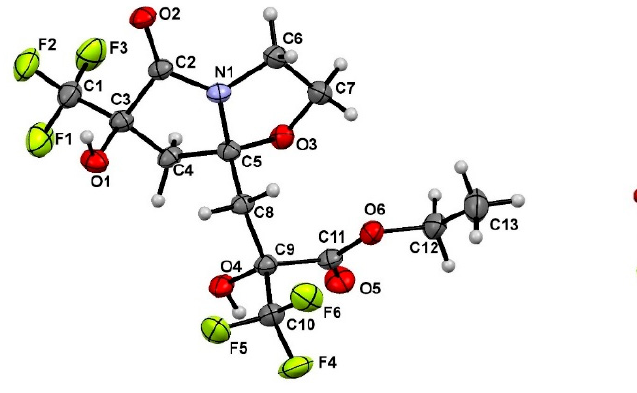
( b ) Figure 3. The ORTEP view of compounds 4d c ( a ) and 8c c ( b ) according to XRD data. A more difficult task was to determine the structure of heterocyclic aldols 5 tc , 5 cc , 9 , 9’ and 10 , 10’ , which have three or four asymmetric centers, respectively. The diastereomeric structure of pyrrolo[2,1- b ]oxazol-5-one 5 tc was determined using XRD analysis (Figure 4a), conforming to which this compound is a racemic mixture of molecules having the configuration of substituents at the stereocenters С -3– R *, С -5– S *, С - 9– R * according to the numbering presented in Figure 4a. It was found that the hydroxyl